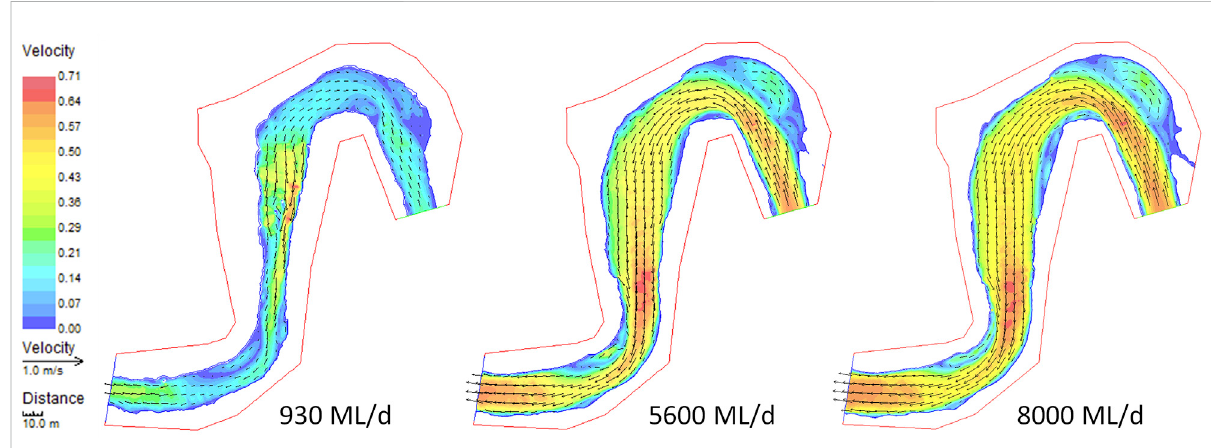
FIGURE 2 Velocityoutputsforthe2DhydraulicmodelattheMcCoy ’ sBridgesite.Plotsshowdepth-averagedvelocitiesatthreedifferentdischargesasper theinsetlabels. Bluecoloursareslowvelocities,throughtoredbeingthehighest.Redborderisthelimitofthechannelareamodelledandiscloseto bankfull elevation.